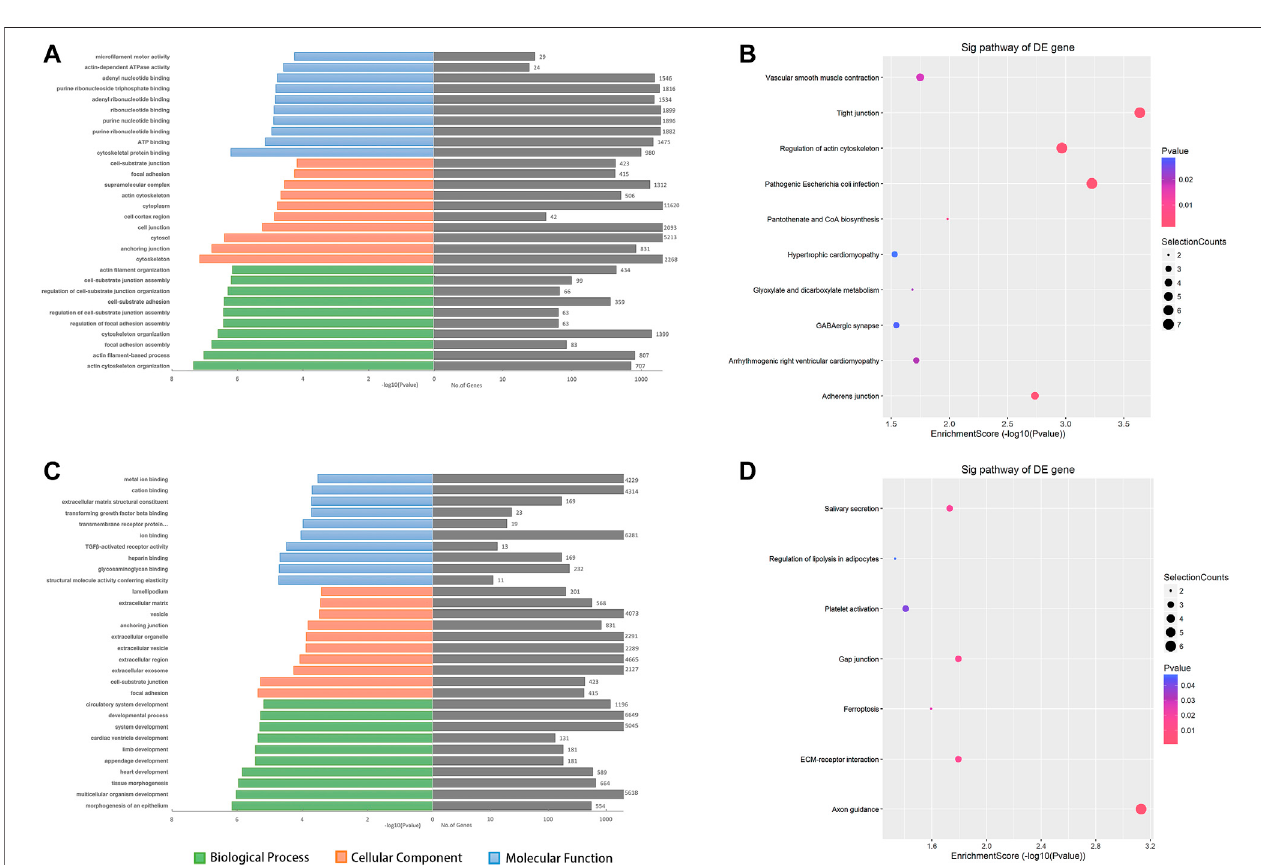
FIGURE 4 | The top 10 GO and KEGG pathway enrichment terms for the predicted target genes of DE circRNAs. GO analysis covered three domains, namely biological processes, cellular components, and molecular functions. The KEGG plot shows the top enrichment score value of the signi fi cantly enriched pathway. (A, B) The upregulated - and (C, D) downregulated circRNAs were analyzed. Abbreviations: ORF, open reading frame.